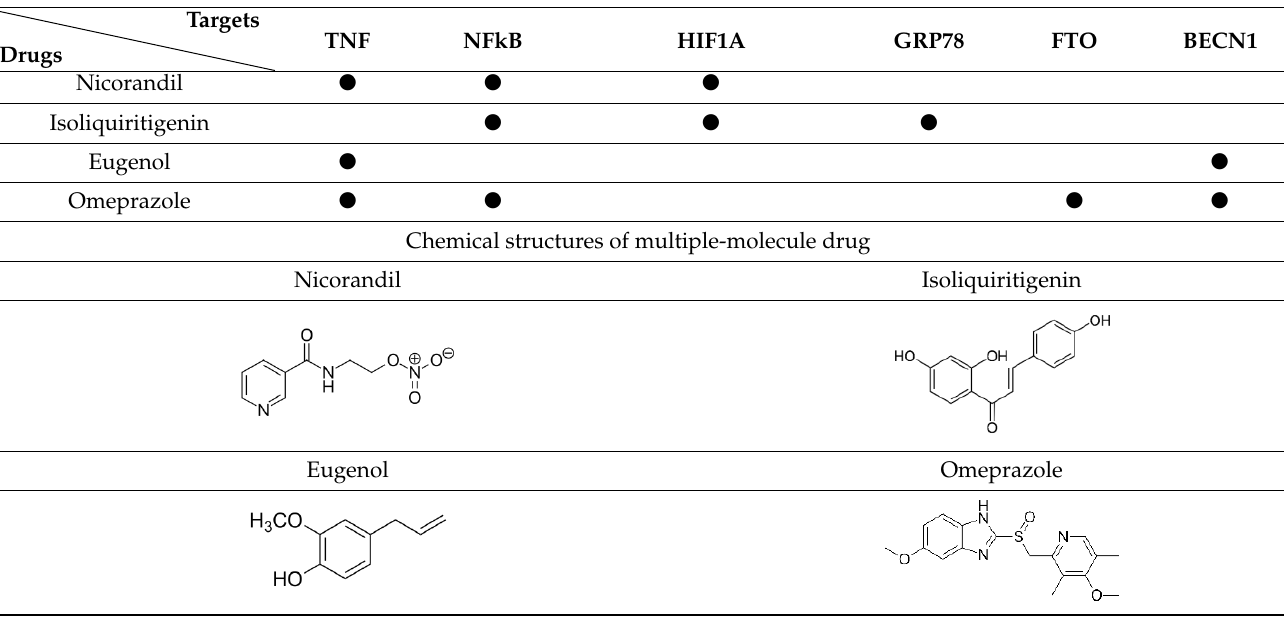
Table 6. Selected drugs and their corresponding drug targets in the multiple-molecule drug therapy for COVID-19-associated ARDS.